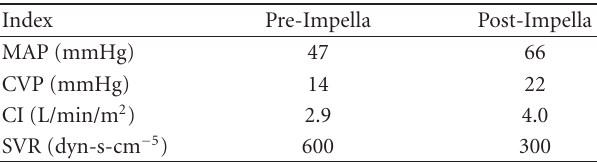
Table 1: Changes in hemodynamic parameters following Impella